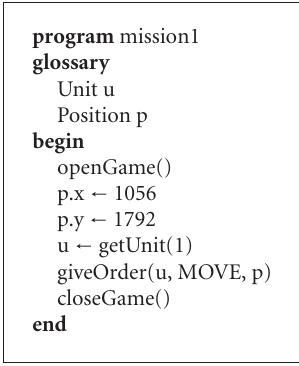
Algorithm 1: Mission one